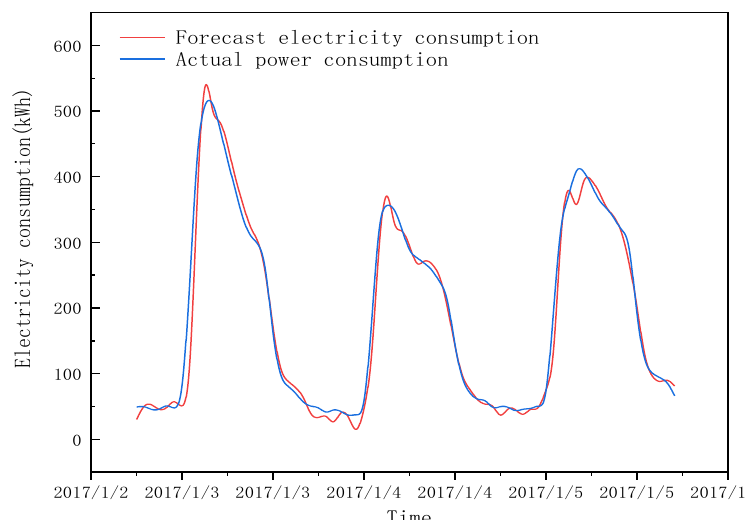
Figure 10. Forecast of air conditioning energy consumption in winter working days.